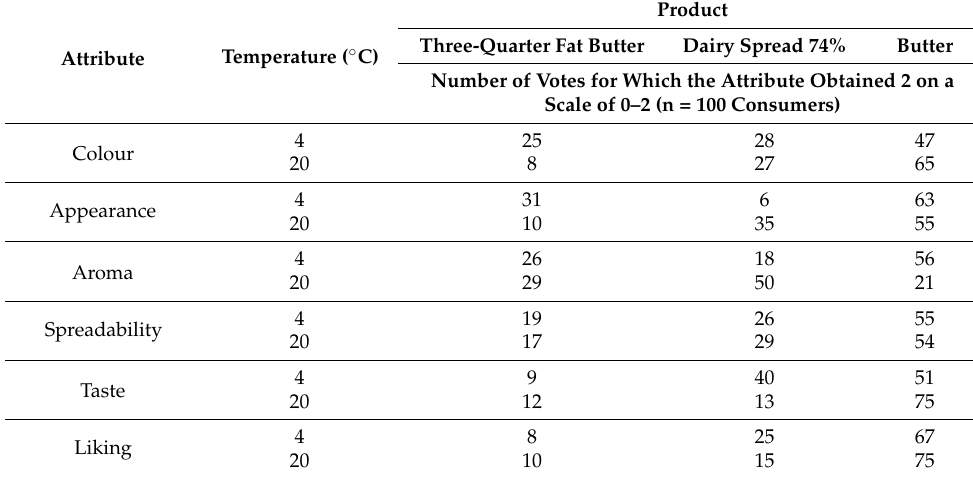
Table 5. The preferences (%) regarding colour, appearance, aroma, spreadability, taste and an overall preference for milk fat products (n =